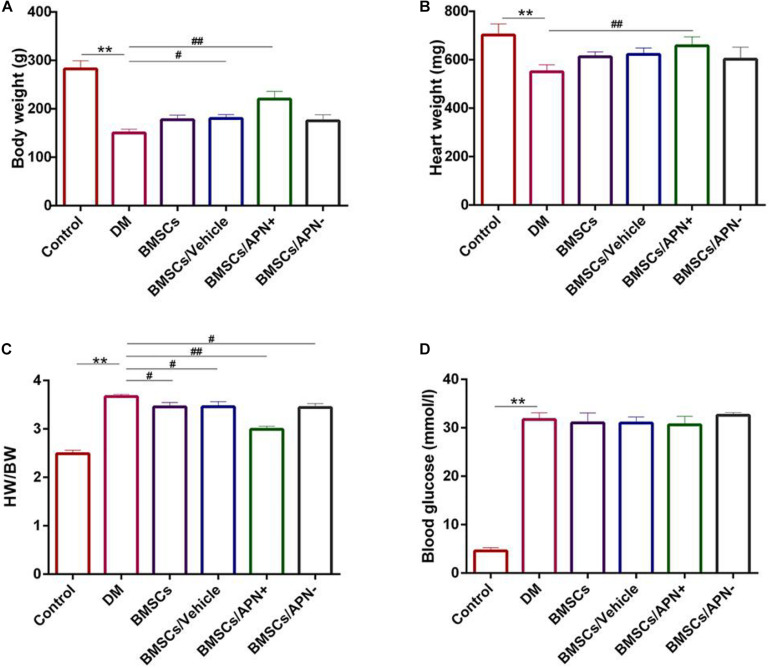
Basic characteristics of experiment groups changes at 6 weeks. (A) Body weight (g). (B) Heart weight (mg). (C) Heart weight to body weight ratio (HW/BW). (D) Blood glucose (mmol/l). Date are mean ± SD; *p < 0.05, **p < 0.01, #P < 0.05, vs DM, ##P < 0.01, vs DM.